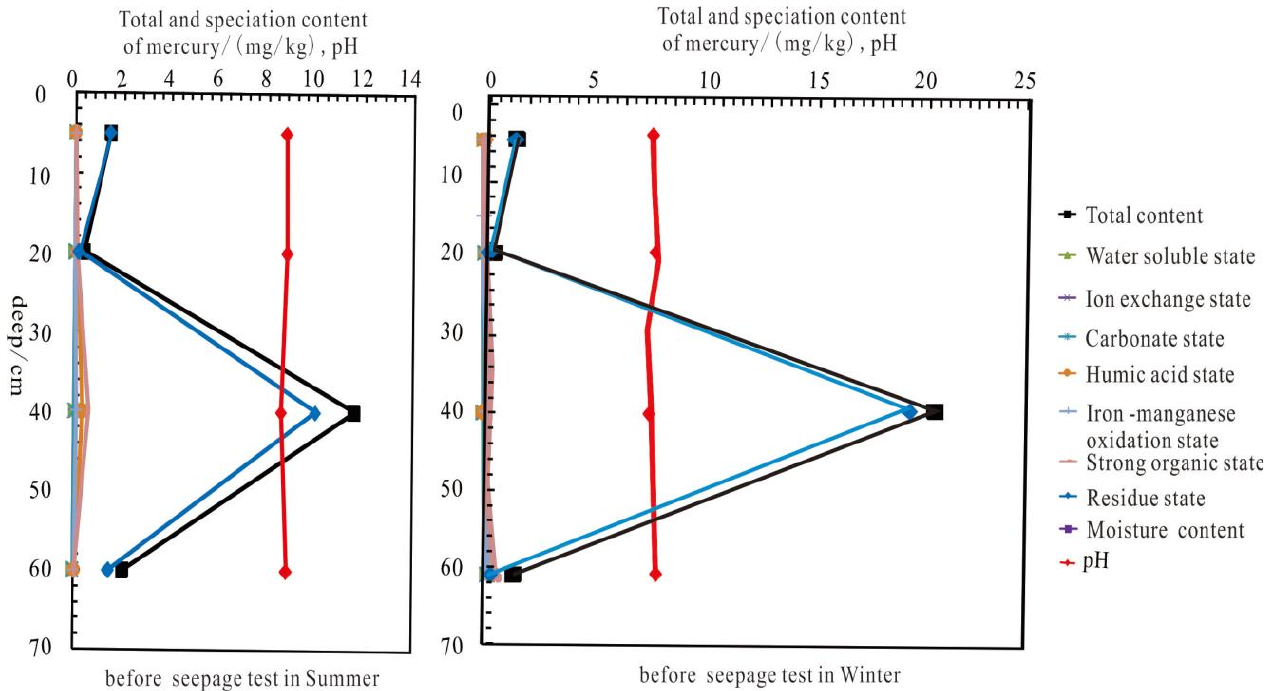
Figure 2. Occurrence forms of mercury in the soil layer of the vadose zone before the water seepage test was performed in the dry and wet periods.